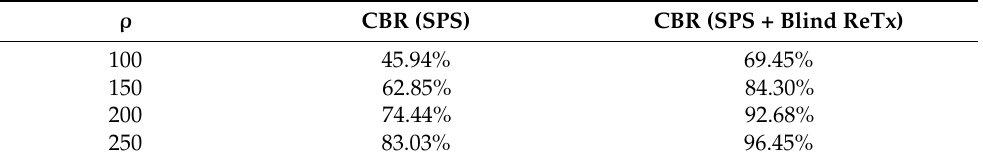
Table 1. Channel busy ratio (CBR) for various traffic densities.